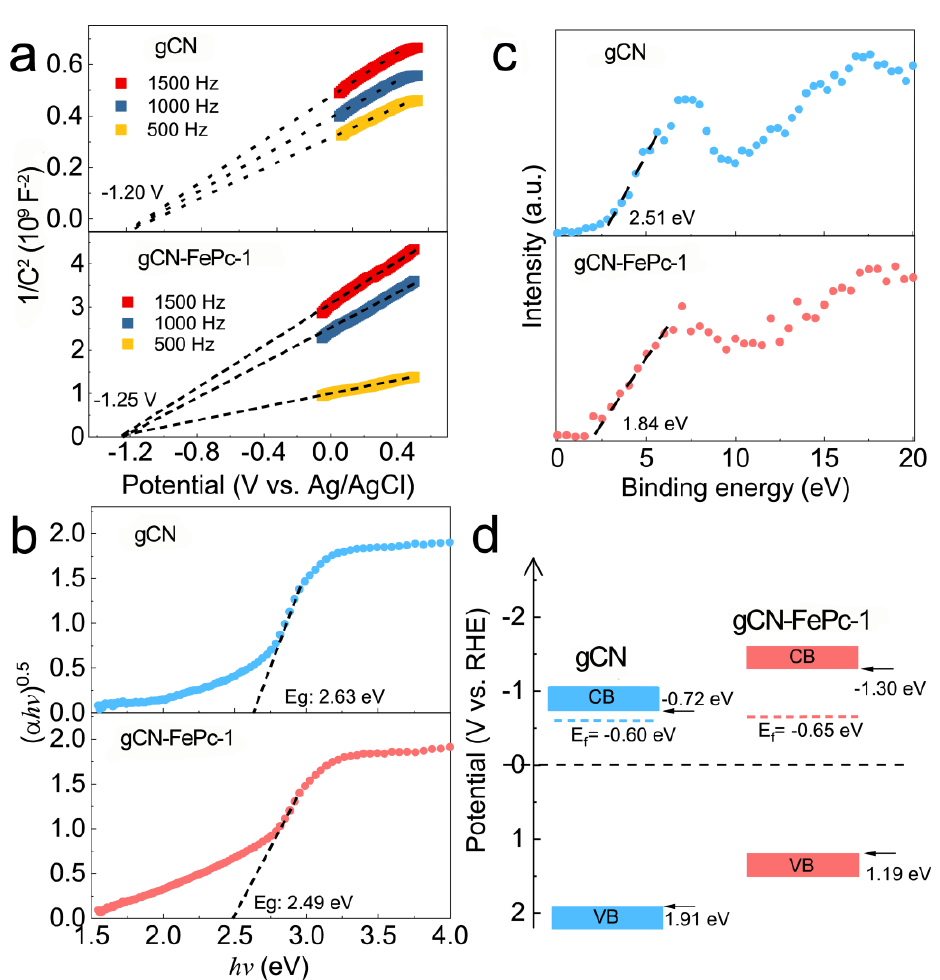
Figure 9. Mott – Schottky curves ( a ), Tauc plots ( b ), XPS VB spectra ( c ), and band structure ( d ) of gCN and gCN-FePc-1.